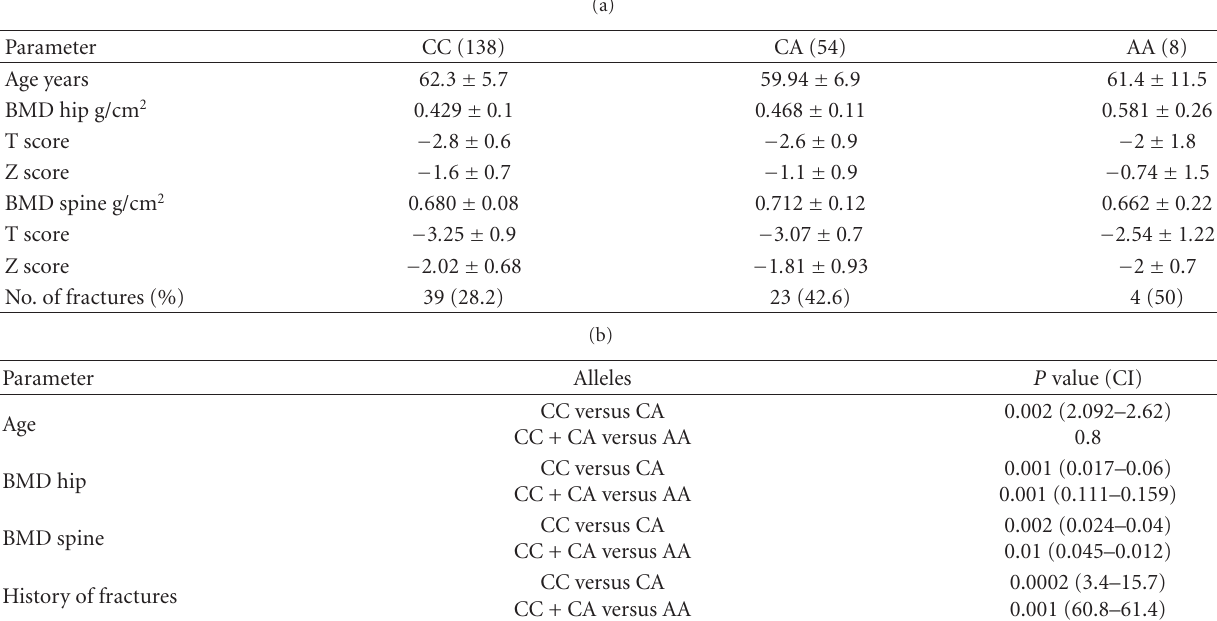
Table 1: (a) Demographic data of ALOX15 17p13 (rs7220870) of CC, CA, and AA alleles. (b) Statistical analysis of the ALOX15 17p13 (rs7220870) 3 alleles.